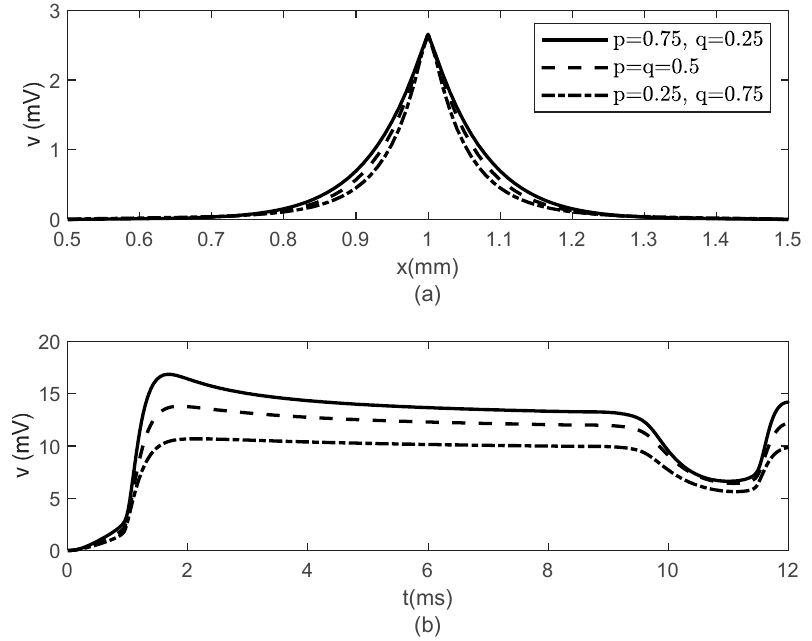
Figure 6. ( a ) Spatial variations of 𝑣(𝑥,𝑡) at 𝑡 = 0.1 ms , and ( b ) temporal variations of 𝑣(𝑥, 𝑡) at 𝑥 = 700 μm for various values of 𝑝, 𝑞 . Here, 𝛼 = 0.65 and 𝛽 = 0.7.